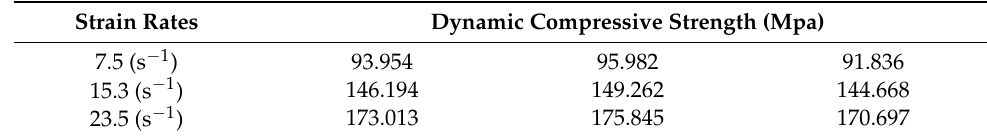
Table 6. Dynamic compressive strength under different strain